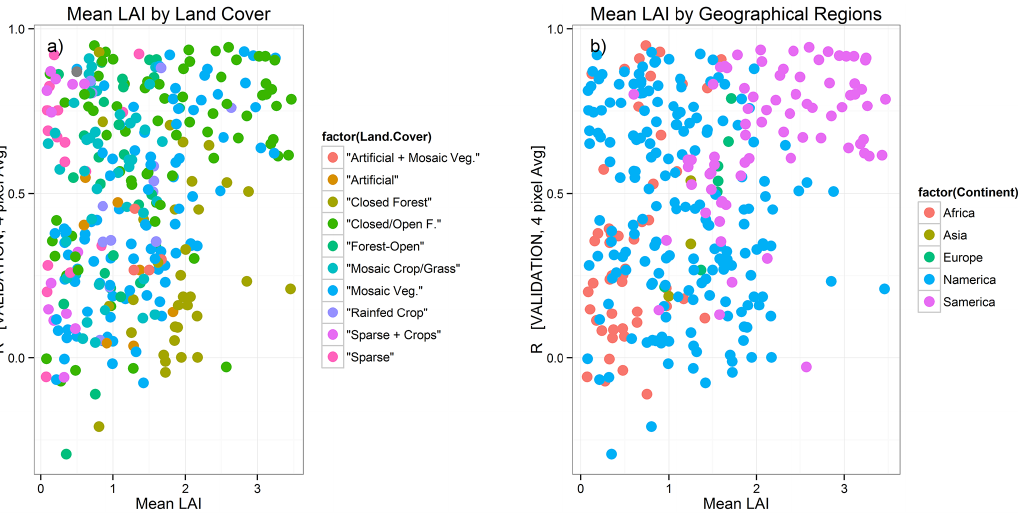
Figure 10. Evaluation of the R score obtained during the validation and its classification by LAI according to factors of (a) land cover and (b) geographical regions (contintent).